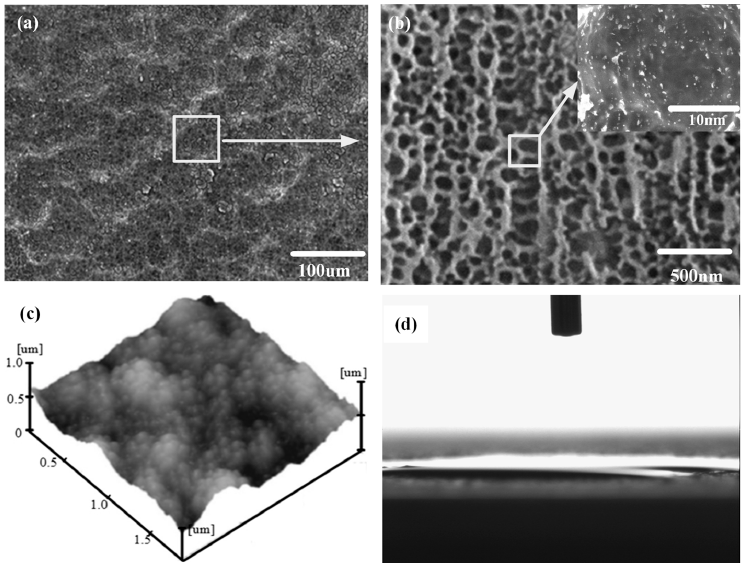
Figure 4. Images of SEM, AFM and a water droplet on the Al alloy surfaces after being treated by electrochemical machining. ( a ) SEM image with 200 magnification; ( b ) SEM image with 2000 and 50,000 magnification; ( c ) AFM image; ( d ) water droplets with a volume of 5 μ L.